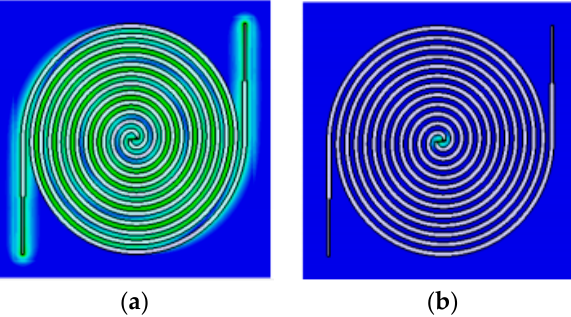
Figure 4. Current distribution over the Archimedean spiral antenna at 0.35 GHz ( a ) and 10 GHz ( b ).